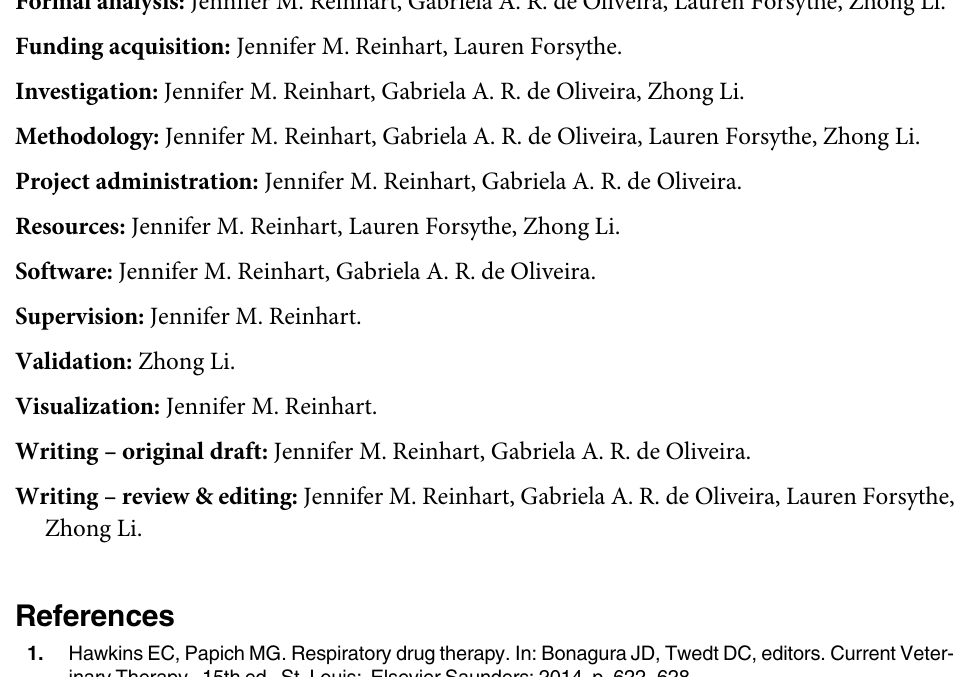
S1 Fig. Individual dog steady state predictions. Steady statement plasma theophylline con- centration predictions for individual dogs when administered 10 mg/kg OFT twice daily (thick solid line). The thin dotted lines represent the theophylline therapeutic range established for adult humans (10–20 μ g/mL) and the thin dashed lines represent a proposed range for use in dogs (5–30 μ